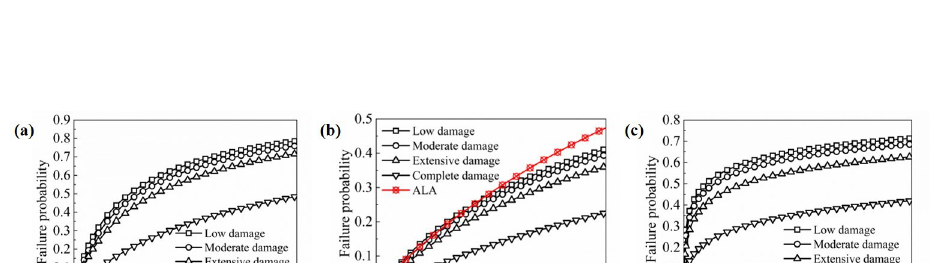
PLOS ONE | https://doi.org/10.1371/journal.pone.0271533 August 22,